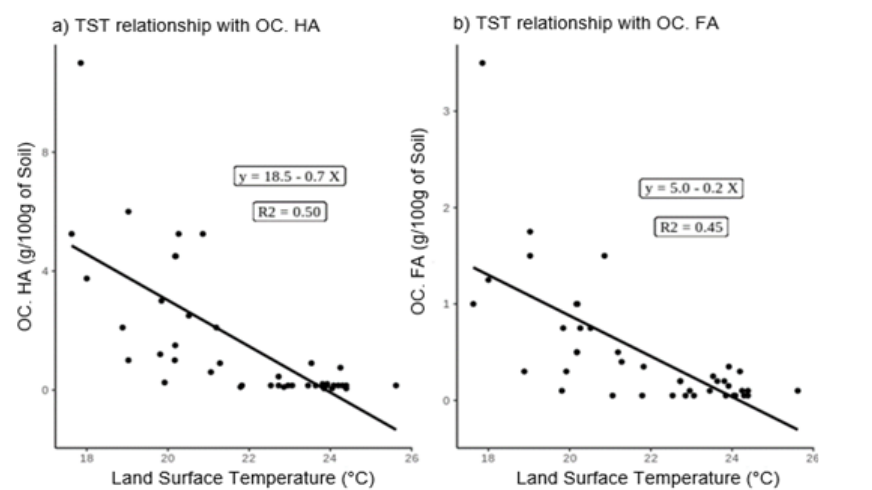
Figure 5: Relationship between Land Surface Temperature (LST) and organic carbon contents. a) LST with OC in humic acids and b) TST with OC fulvic